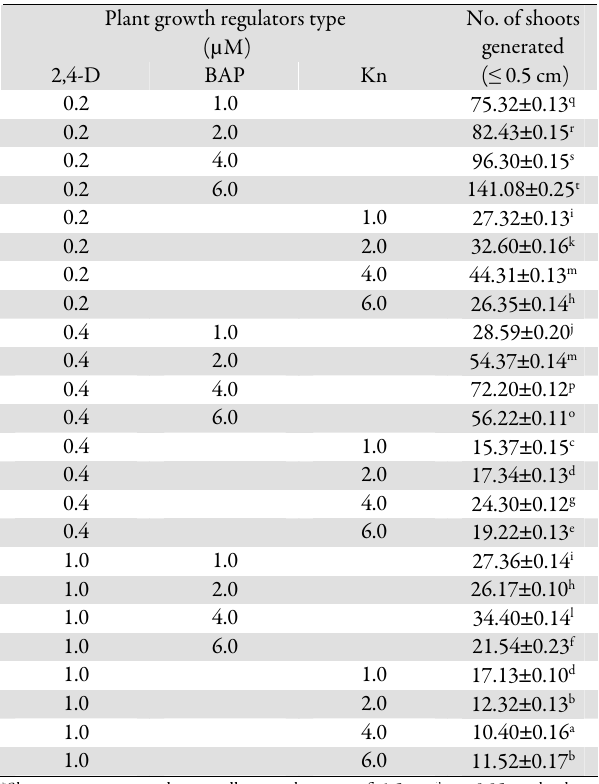
Tab. 2. The effect of media with different phytohormones on the regenerated rate of Zingiber officinale